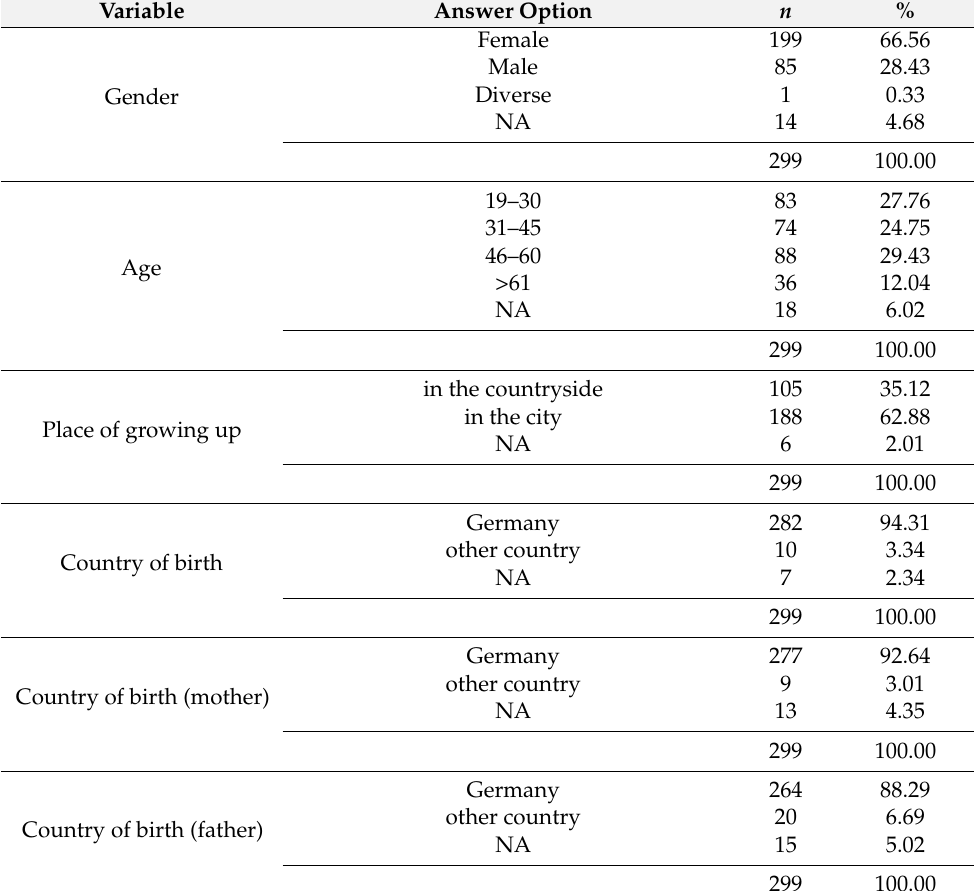
Table A2. Overview of socio-demographic information of study participants ( n = 299) by number and percent (rounded to two decimal